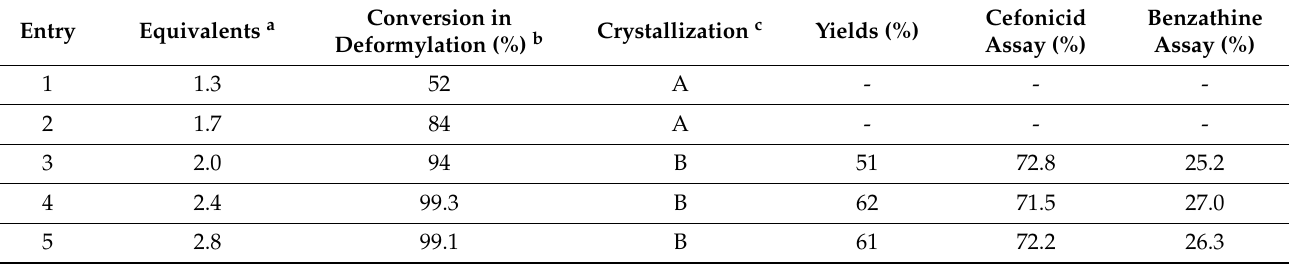
Table 3. Reactivity study of formyl cefonicid with different N (cid:48) , N ”-dibenzylethylenediamine diacetate ( 5 )